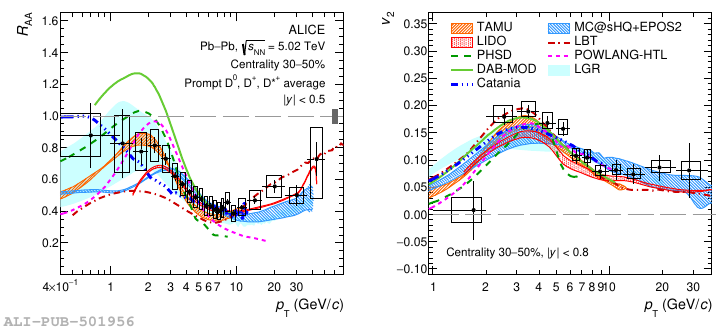
Figure 4. Comparison of R AA and v 2 measurements in semiperipheral events with di ff erent models